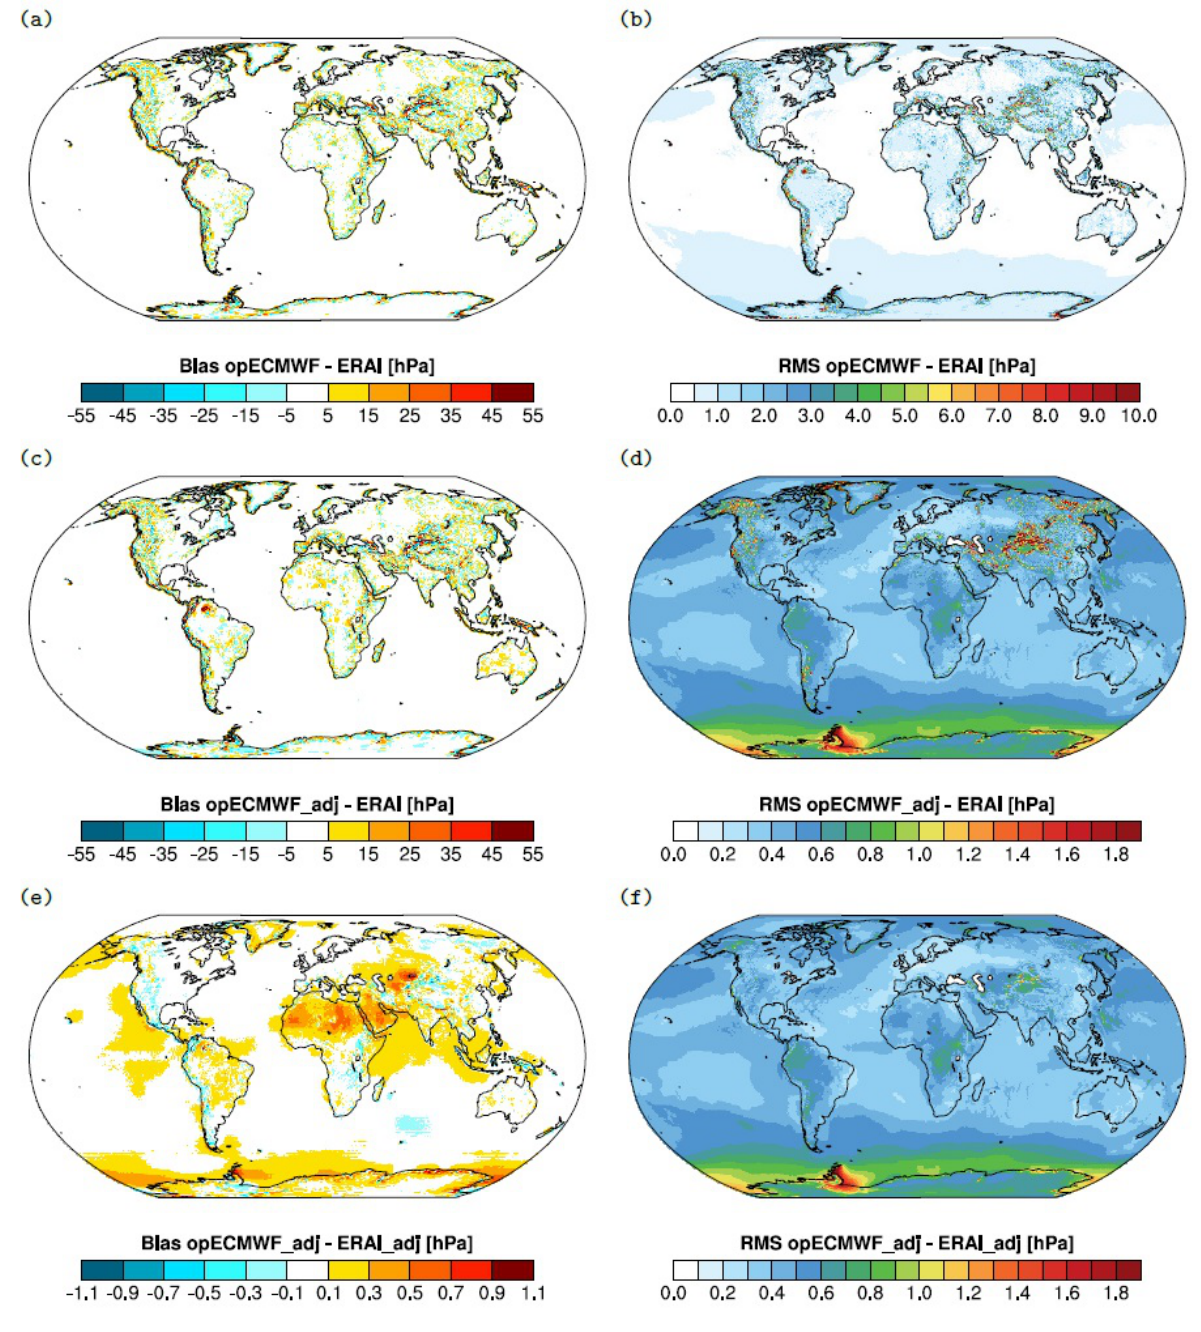
Figure 1: Relative biases (left column) as well as RMS of zero-centered residuals (right column) of two different surface pressure data sets available at 6-hourly resolution over the period January 1st, 2001 – June 30th, 2015 on a 0.5 ∘ grid: (top row) raw surface pressure from the operational ECMWF analyses and ERA-Interim reanalyses; (middle row) surface pressure from the operational ECMWF analyses reduced to a reference orography and raw surface pressure from ERA-Interim reanalyses; and (bottom row) surface pressure from the operational ECMWF analyses and ERA-Interim reanalyses both reduced to the same reference